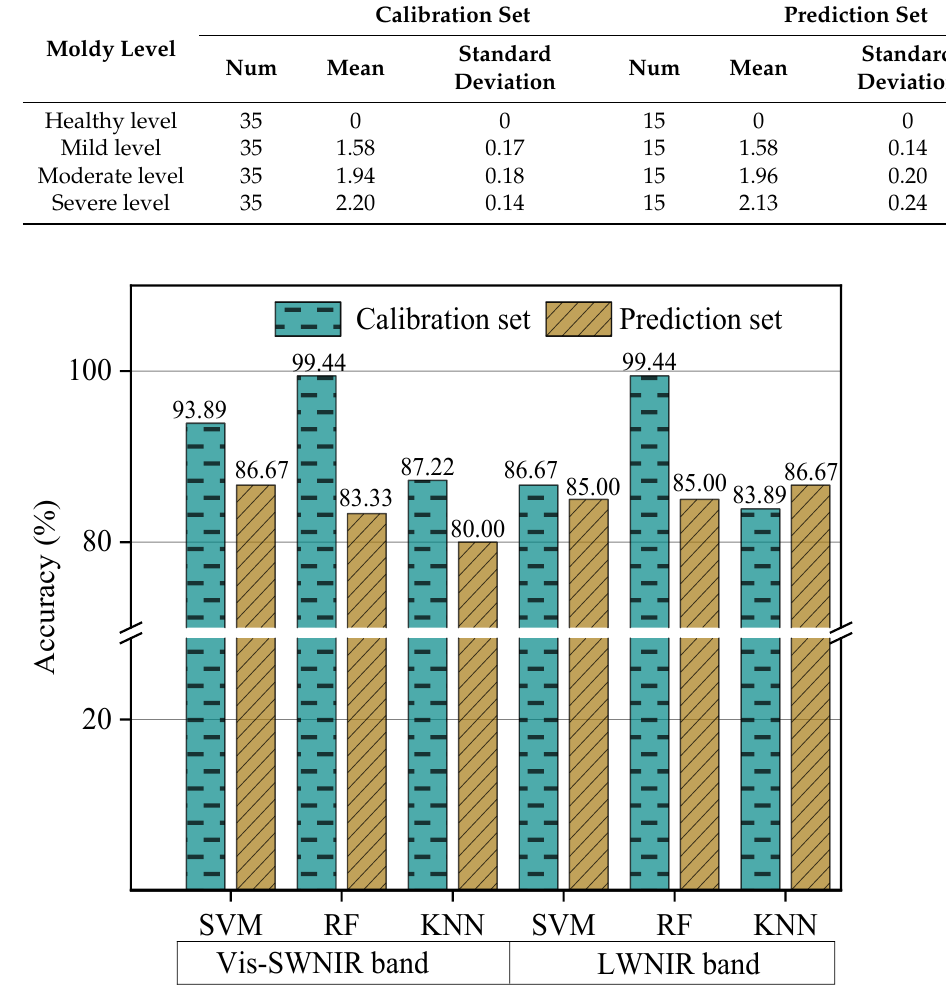
Figure 5. The classification results of different classifiers based on the original spectra of Vis-SWNIR and LWNIR hyperspectral systems.